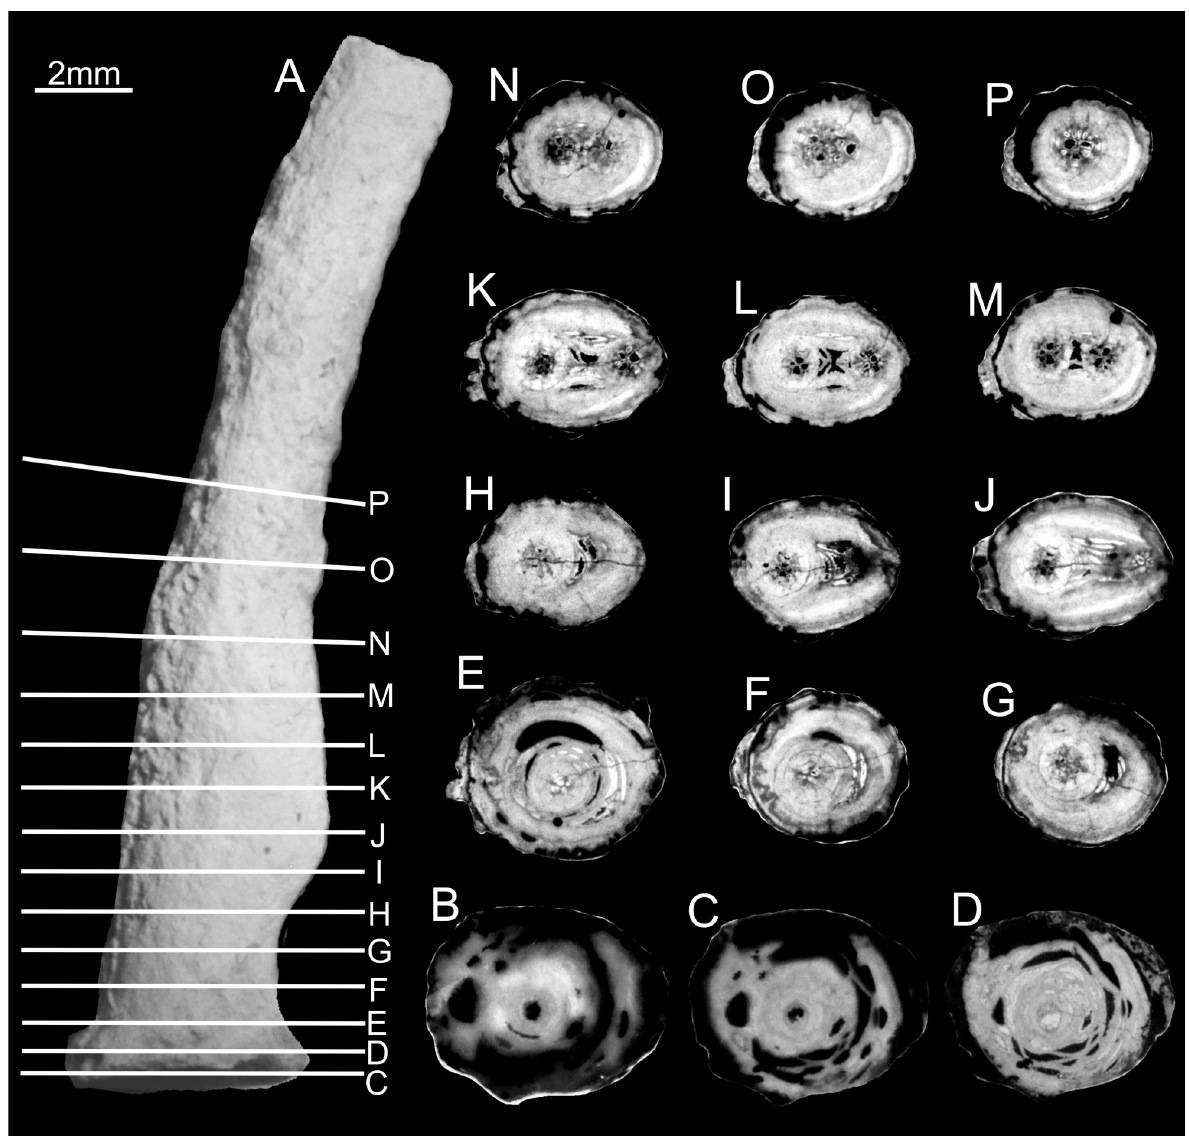
Fig 6. Juvenile specimen of Oligophylloides sp. UAM/He/B/020. A–external view, white lines show the planes of cuttings; B-P–successive serial transversal thin sections showing successive ontogenetic growth stages. Note H-O show formation of the new central lumen, which disappears on the P section. Scale bar 2